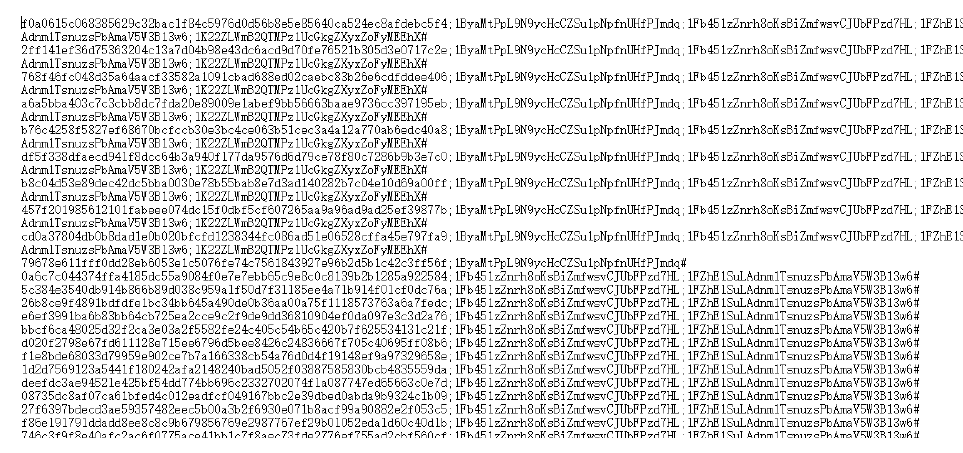
Table 3. Time comparison table of three retrieval algorithms under different block file sizes (unit: ms).